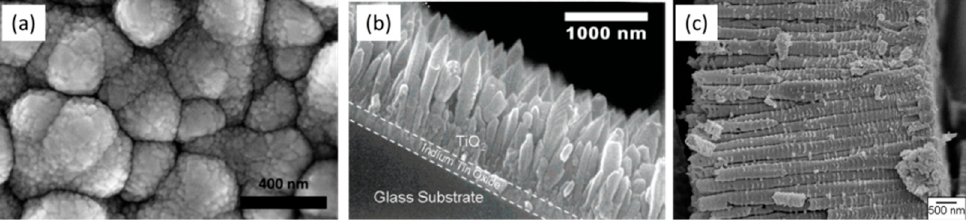
Figure 9. SEM images of different titania nanostructures for PEC electrodes: rough nanobeads ( a ) adapted with permission from [135], Copyright 2015, American Chemical Society, columnar ( b ) adapted with permission from [160], Copyright 2008, American Chemical Society, and tubular structures ( c ) adapted with permission from [144], Copyright 2009, American Chemical Society.